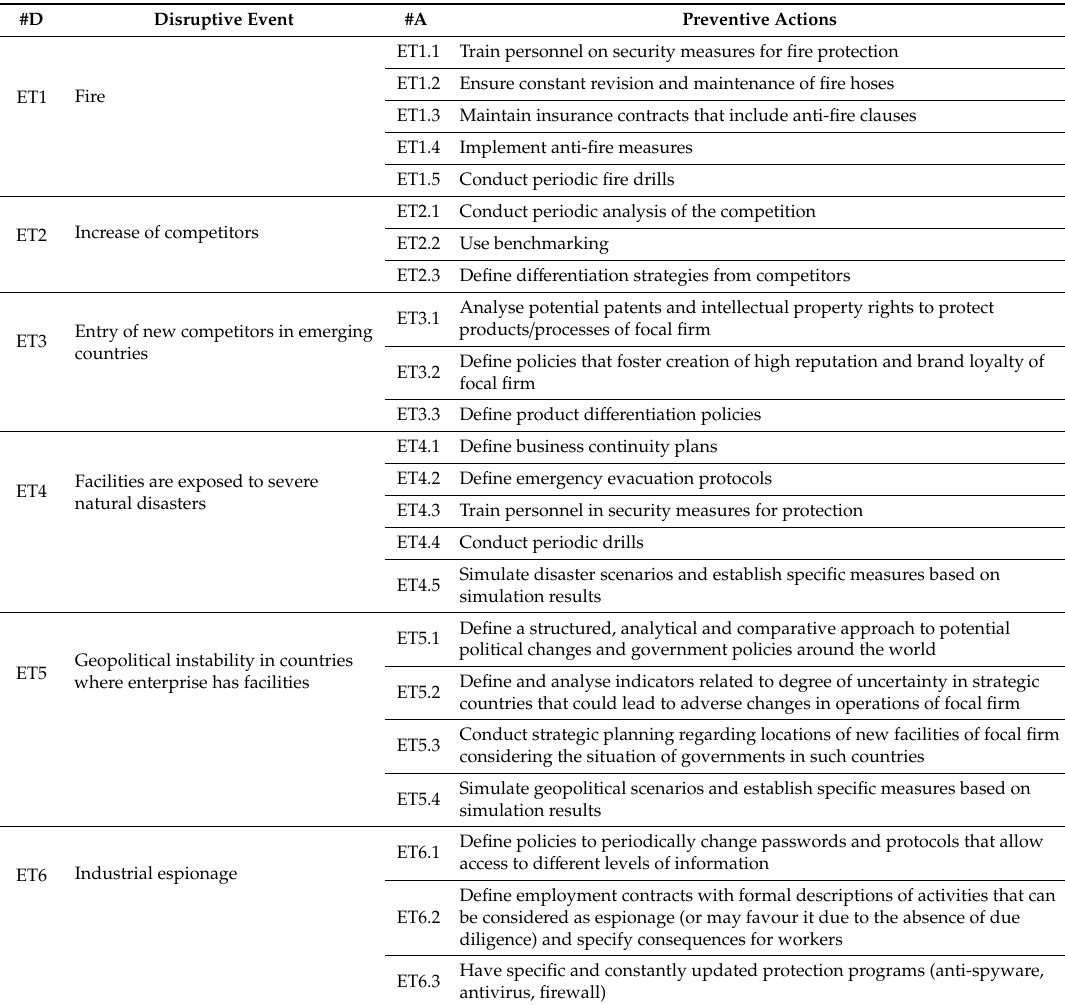
Table 7. Summary of disruptive events related to environmental and context-related aspects and preventive